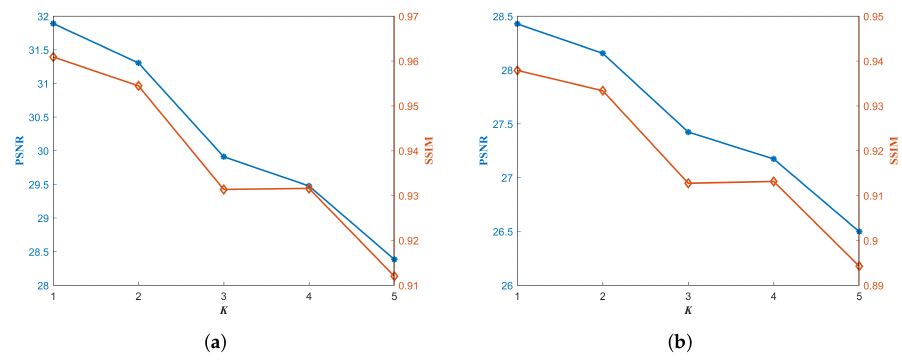
Figure 13. Two sets of PSNR (dB) and SSIM results for Lena with different K values respectively in the cases of adding stripe noise of σ = 0.08 and 0.16. ( a ) PSNR and SSIM when σ = 0.08; ( b ) PSNR and SSIM when σ =